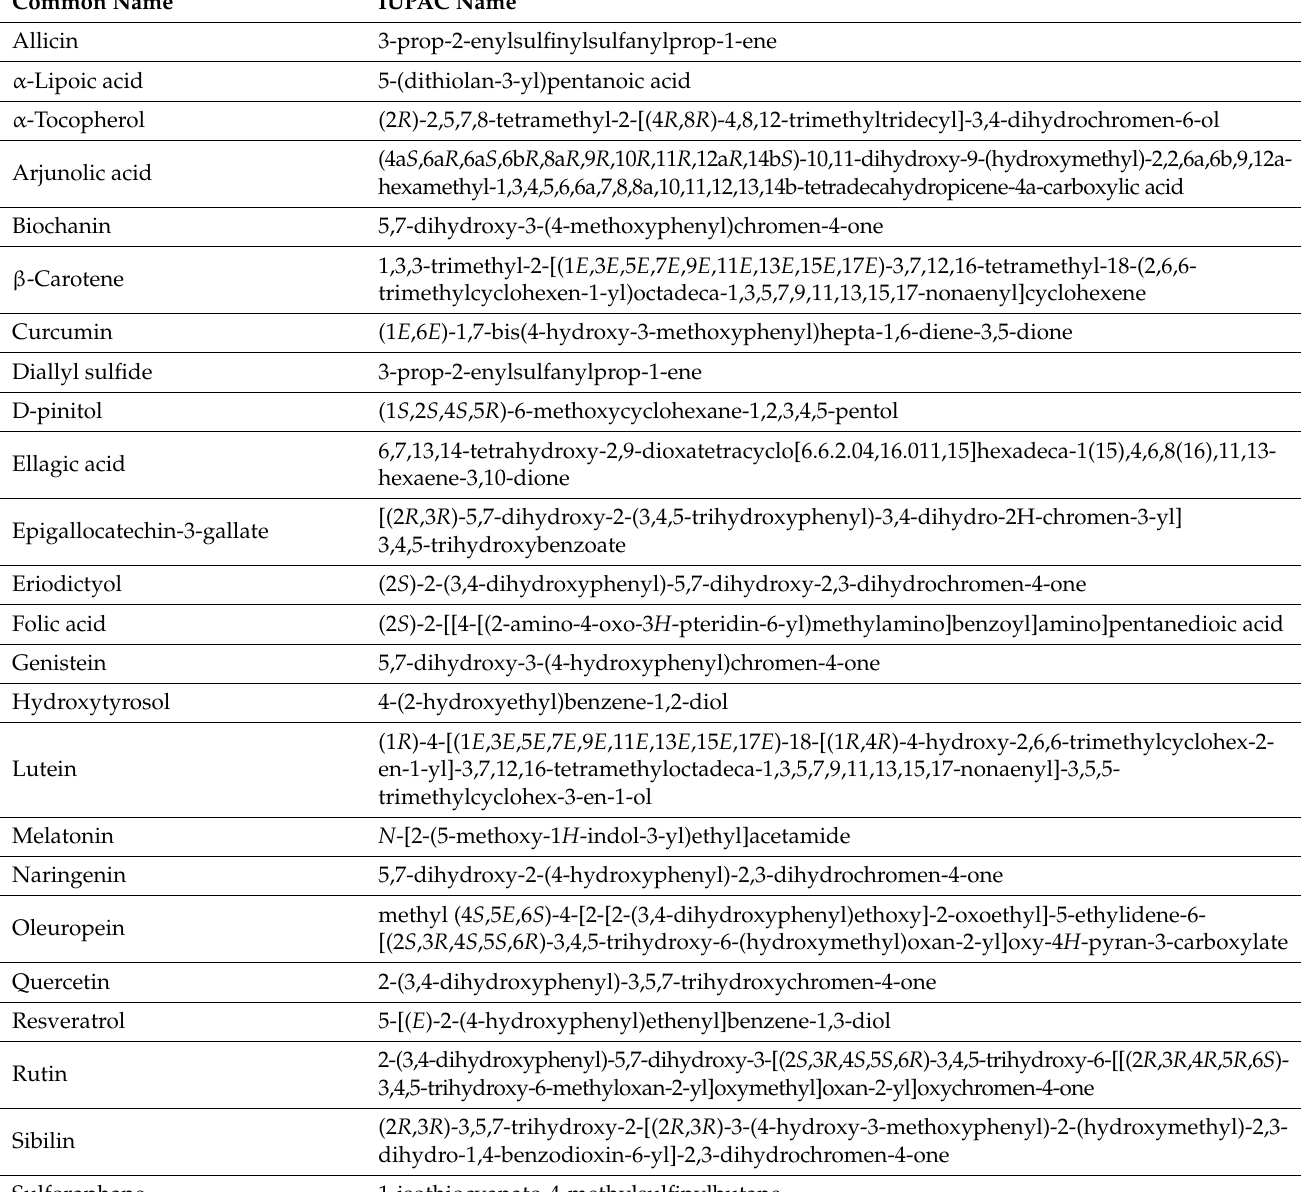
Table 1. Natural compounds active in alleviating arsenic